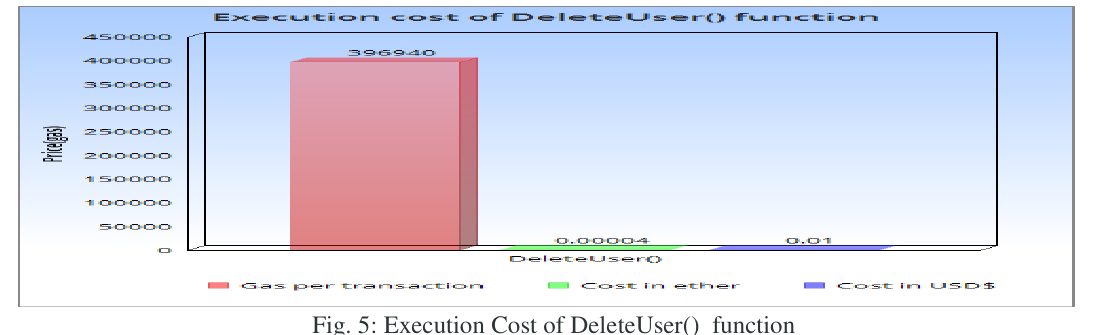
Fig. 5: Execution Cost of DeleteUser()